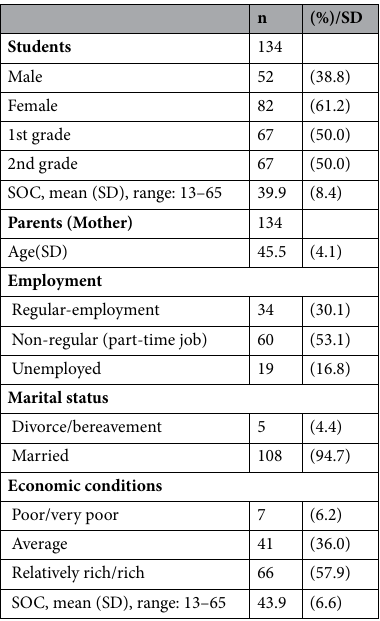
Table 1. Attributes and characteristics of participants. Missing values are excluded from the table. SOC sense of coherence.